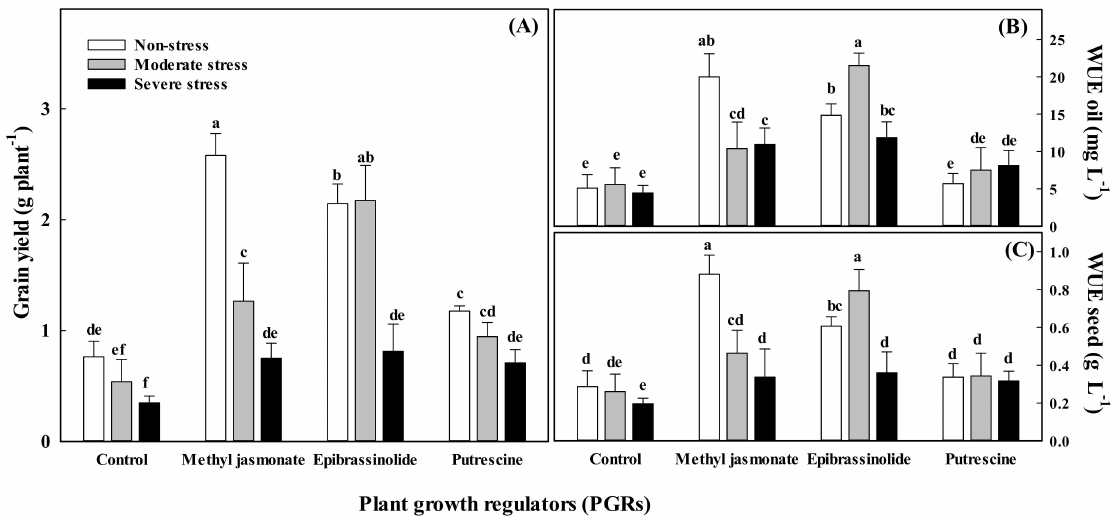
Figure 1. Interactive effect of plant growth regulators and water stress intensity on ( A ) grain yield, ( B ) water use efficiency for essential oil production, and ( C ) water use efficiency for seed yield of fennel ( Foeniculum vulgare Mill.) at vegetative stage. Data are means ( n = 3), and bars represent standard errors of the mean. In each panel, means with same letter (a, b, c, . . . ) do not differ significantly ( p <